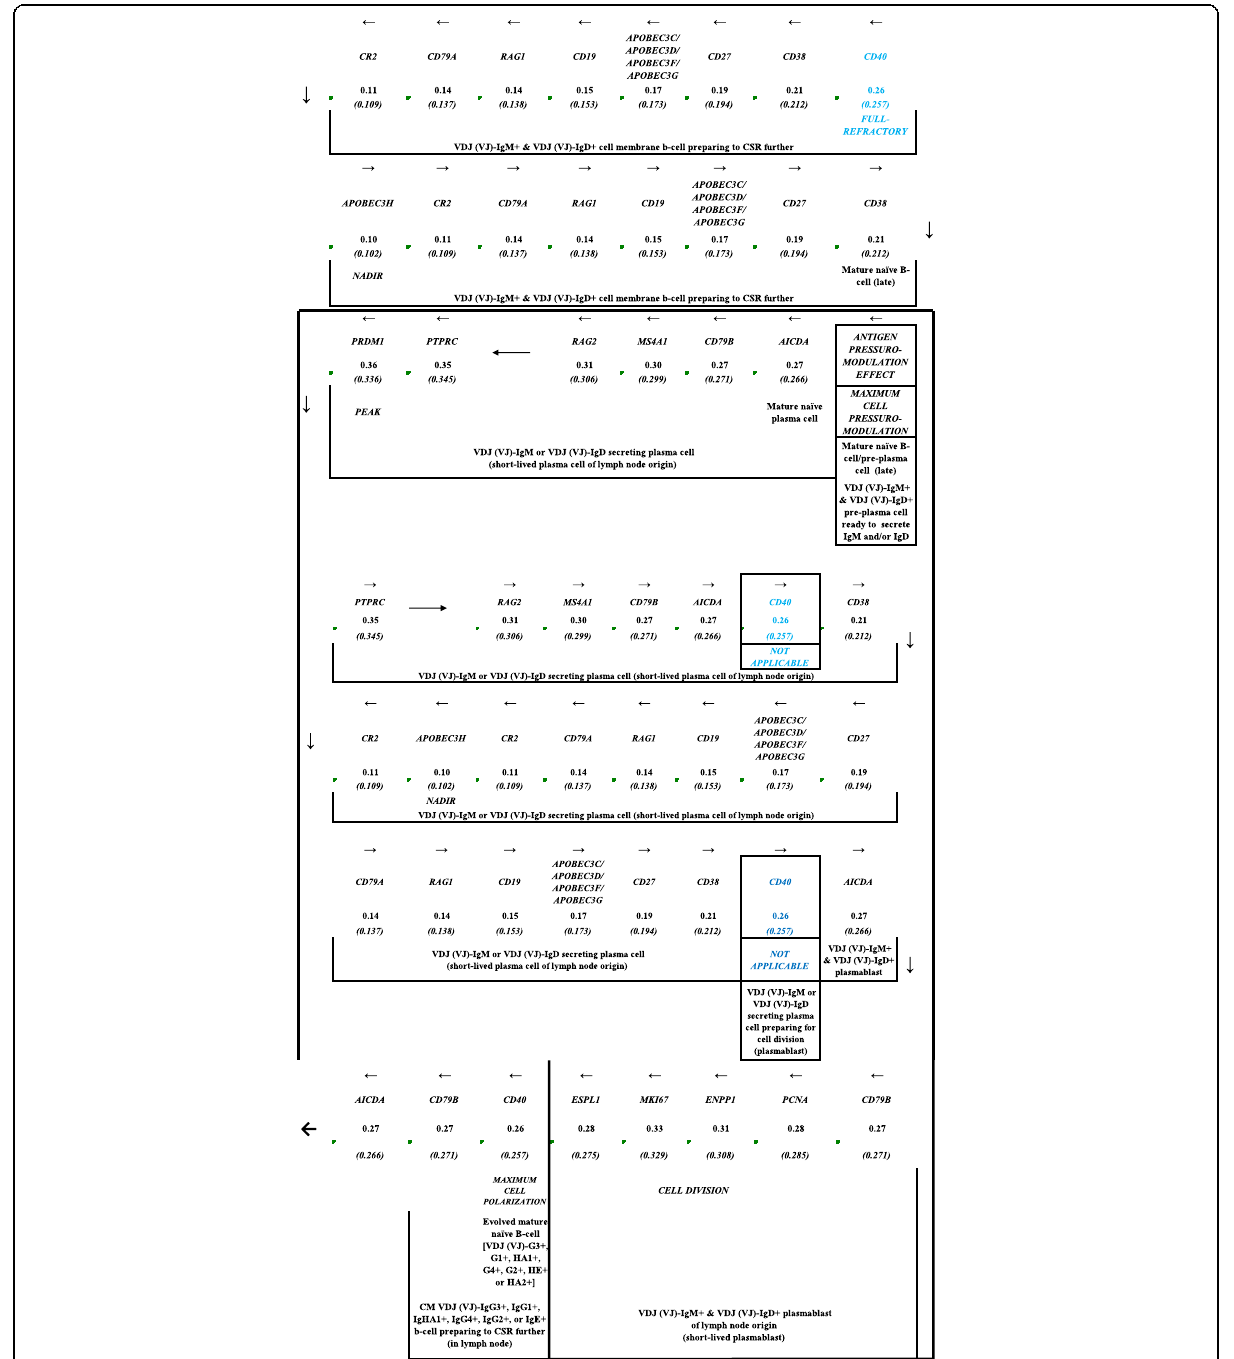
Fig. 1 Allele 1 (IGHM) 2-step and 1-step Ig heavy chain locus gene rearrangement recombination steps superimposed on the pressuromodulation map of B-cell differentiation stages. The Allele 1 two-step recombination steps are IGHD1 – 20 (nf) and IGHJ5 recombination (step 1 of 2), IGHD_-_ genes with respect to D1 – 20(nf)-J5 (step 2a of 2) and IGHJ6 with respect to D1 – 20(nf)-J5 (step 2a of 2) recombination that results that results in IGHD_-_ - IGHJ6 (step 2b of 2) through the final IGHV_-_ and IGHD_-_-IGHJ6 recombination that results in V_-_-DJ6 . The Allele 1 one-step recombination step is IGHD_-_ and IGHJ5 recombination that results in IGHD_-_ - IGHJ5 (step 1 of 1) through the final IGHV_-_ and IGHD_-_-J5 recombin- ation that results in V_-_-DJ6 . Note: Allele 1 locus rearrangement recombination steps complete to the point of the CM IgM+ B-cell before Allele 2 VDJ completes. † , upper esebssiwaagoT Q units range, 0.41 – 0.36. Black, CD40 at maximum cell polarization potential. Dark blue, CD40 at half-refractory. Light blue, CD40 at full-refractory. Text boxes with complete borders, 2-step. Text boxes with dashed borders, 1-step. Large rectangular box with complete borders, extra-nodal secretory antibody